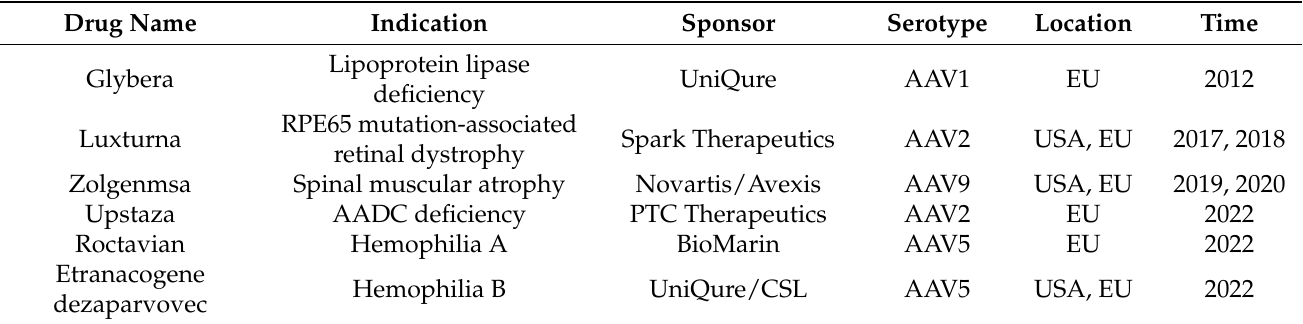
Table 1. List of approved AAV gene therapy drugs. EU, European